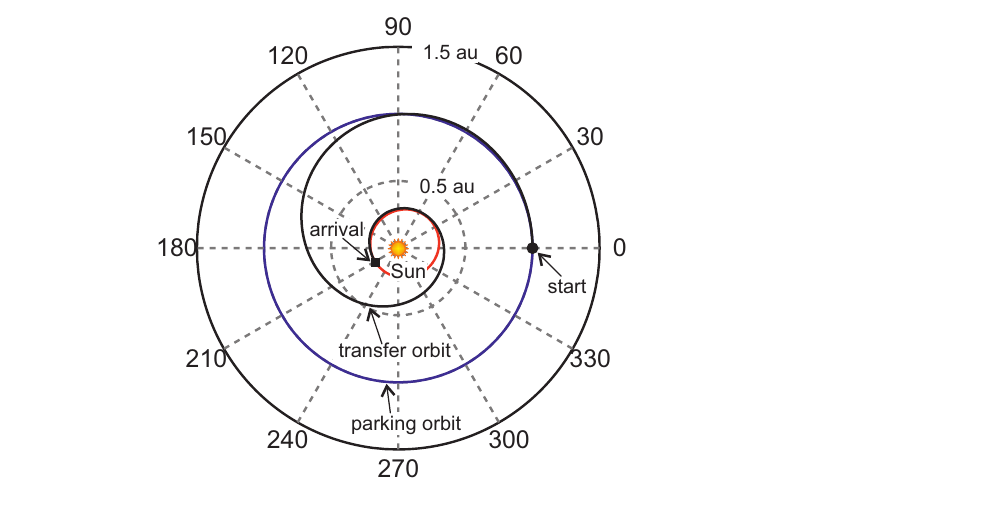
Figure 10. Minimum-time transfer trajectory to reach a heliocentric distance of 0.2au with zero radial velocity (case c).